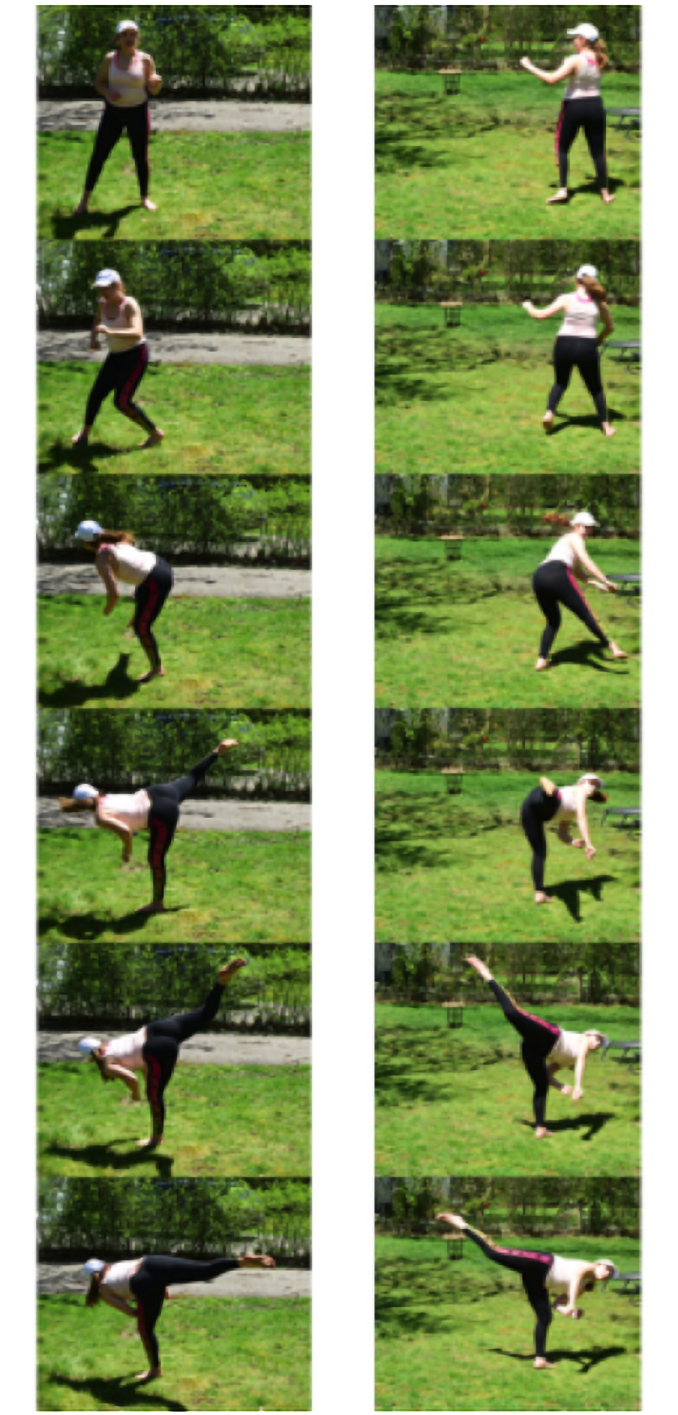
Fig 5. Wheel kick. Two views of a wheel kick, time proceeds downwards. Here, rotation is initiated with the right foot, and deformation of the body (bending at the waist) is used to alter the rotation axis, directing the kick at the opponent’s